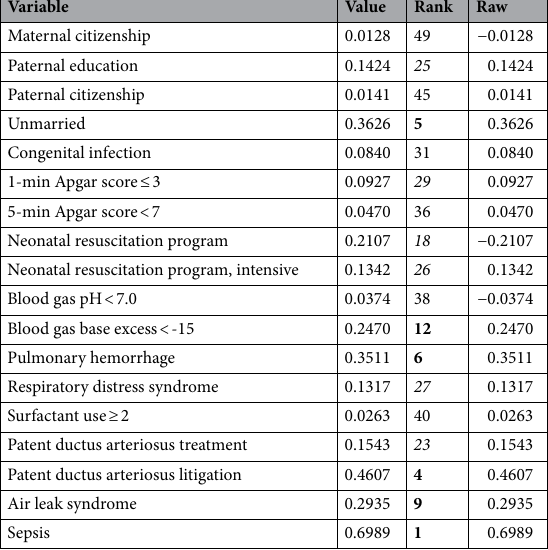
Table 5. Logistic Regression Variable Importance: Temperature Average for Birth Month, Sepsis Included. Abbreviations: DM, Diabetes mellitus; PROM, Pre-labor rupture of membrane; PM 10 , particulate matter concentration. The ranking of a top-15 (or top-30) predictor is highlighted in bold (or